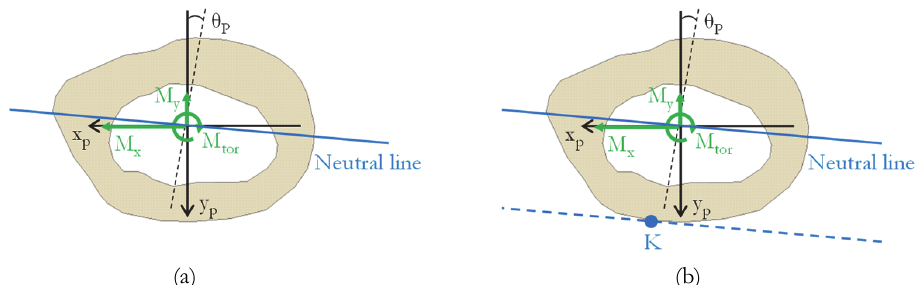
Figure 6: (a) Determination of the neutral line (zero normal stress locus); (b) Locating the point most distanced from the neutral line, at which the maximum normal (tensile) stress is